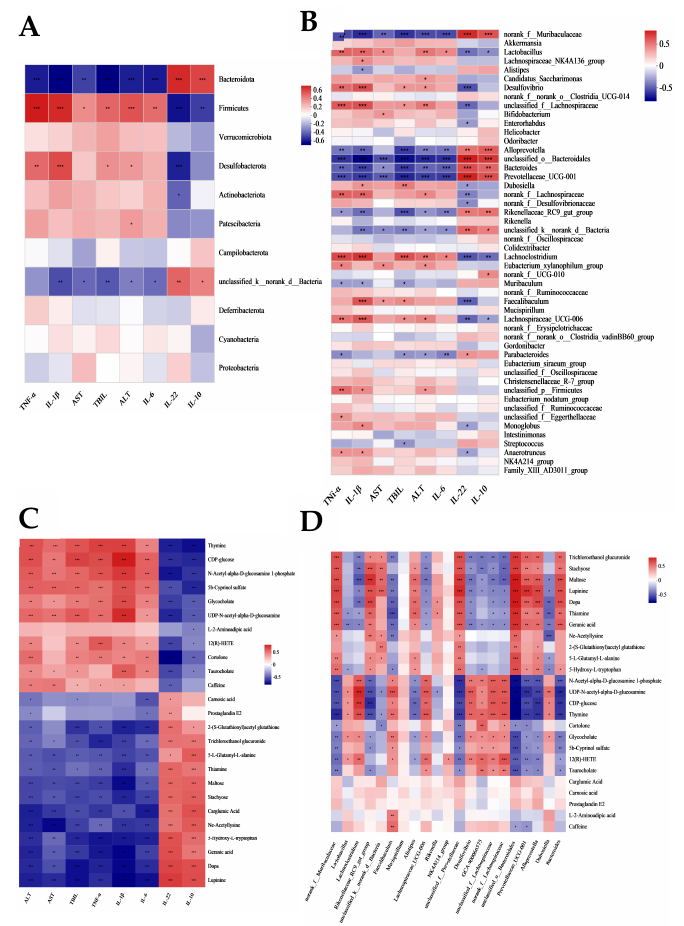
Figure 6. Gut microbiota is linked with liver metabolites and inflammatory markers. ( A , B ) Correla- tions of altered gut microbes with biochemical Indicators on phylum and genus. ( C ) Correlations of altered metabolites with biochemical Indicators. ( D ) Correlation between differential microbiota and metabolic biomarkers. * p ≤ 0.05, ** p ≤ 0.01, *** p ≤ 0.001.